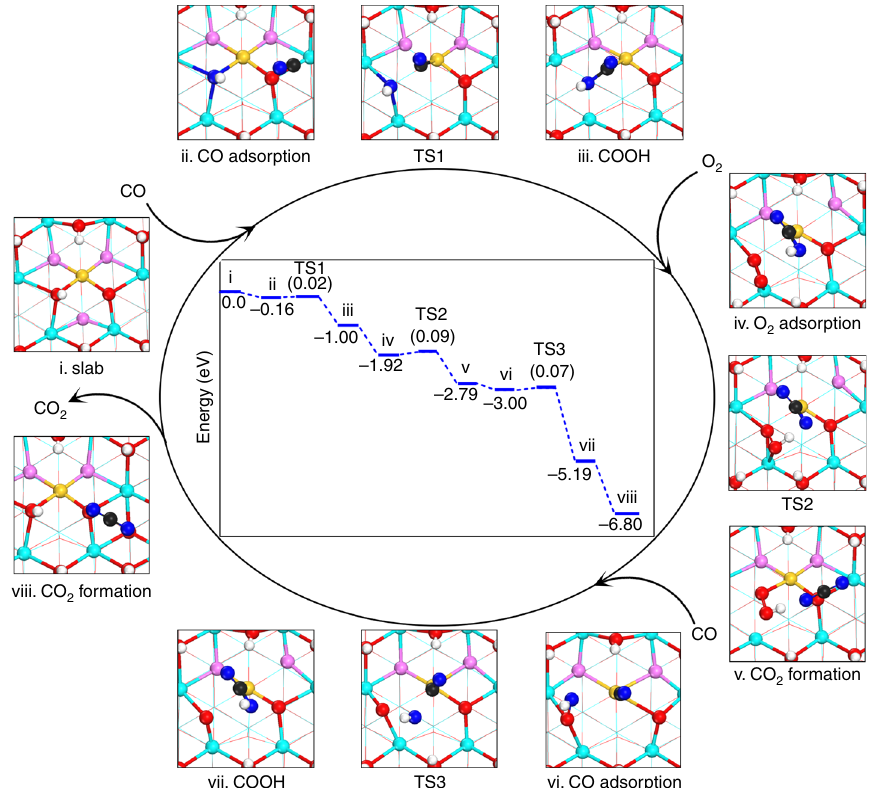
Fig. 3 Reaction pathway B for CO oxidation on the Au 1 /CeO 2 (111). The inset (within the ellipse) shows the potential energy pro fi le and the numbers in the parentheses indicate the barriers (in eV) of elementary